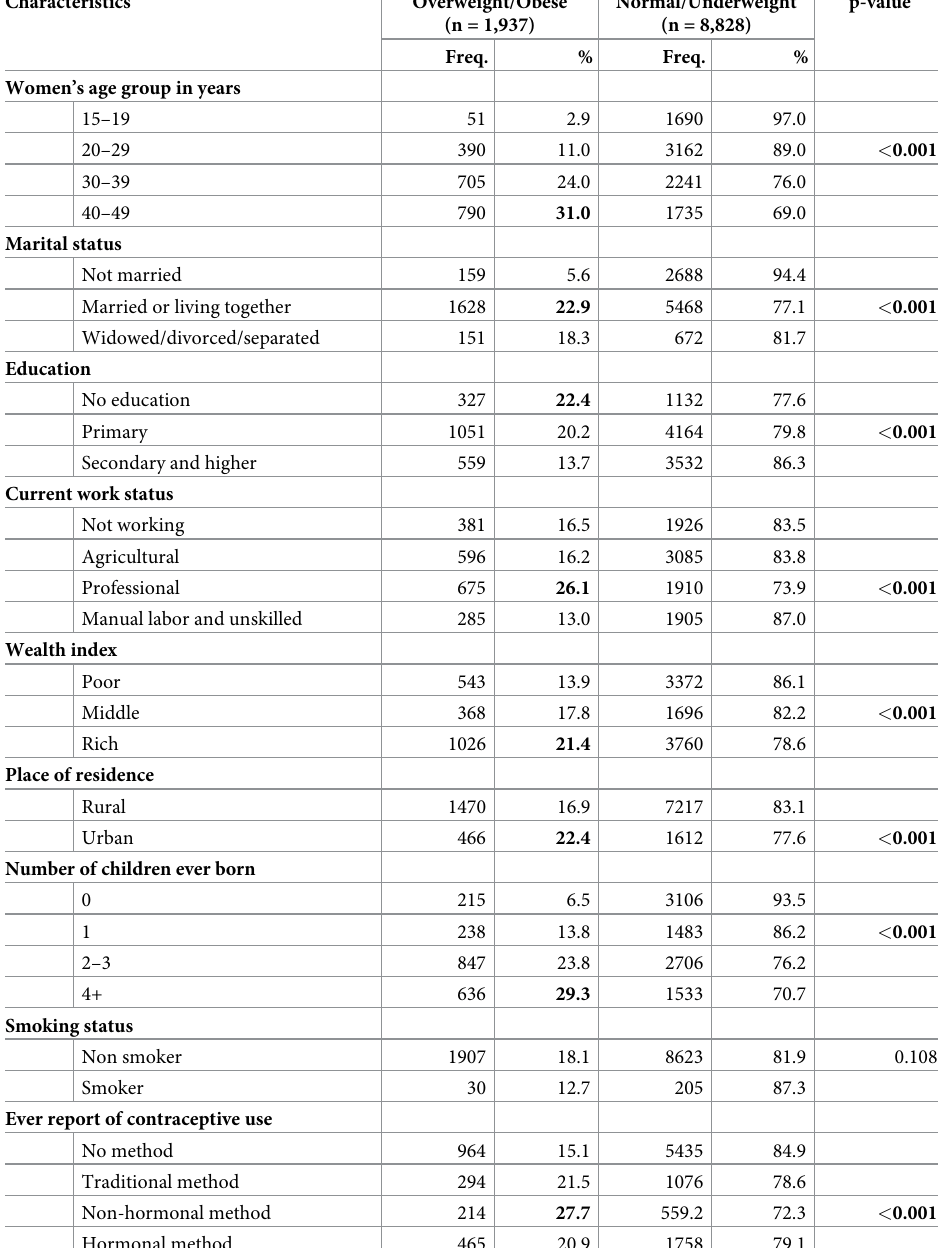
Table 2. Factors associated with overweight and obesity among women aged 15–49 years in Chi 2 analysis (n = 10,765, weighted count). Characteristics Overweight/Obese (n =